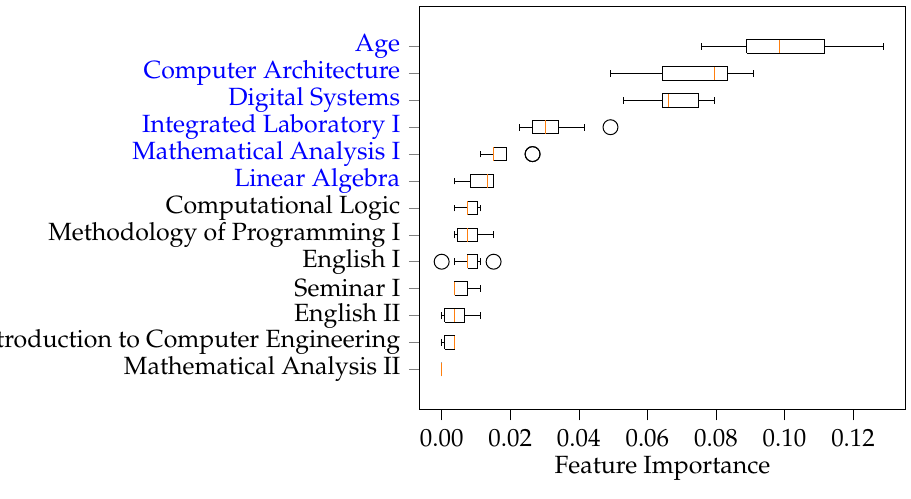
Figure 3. Permutation importance box